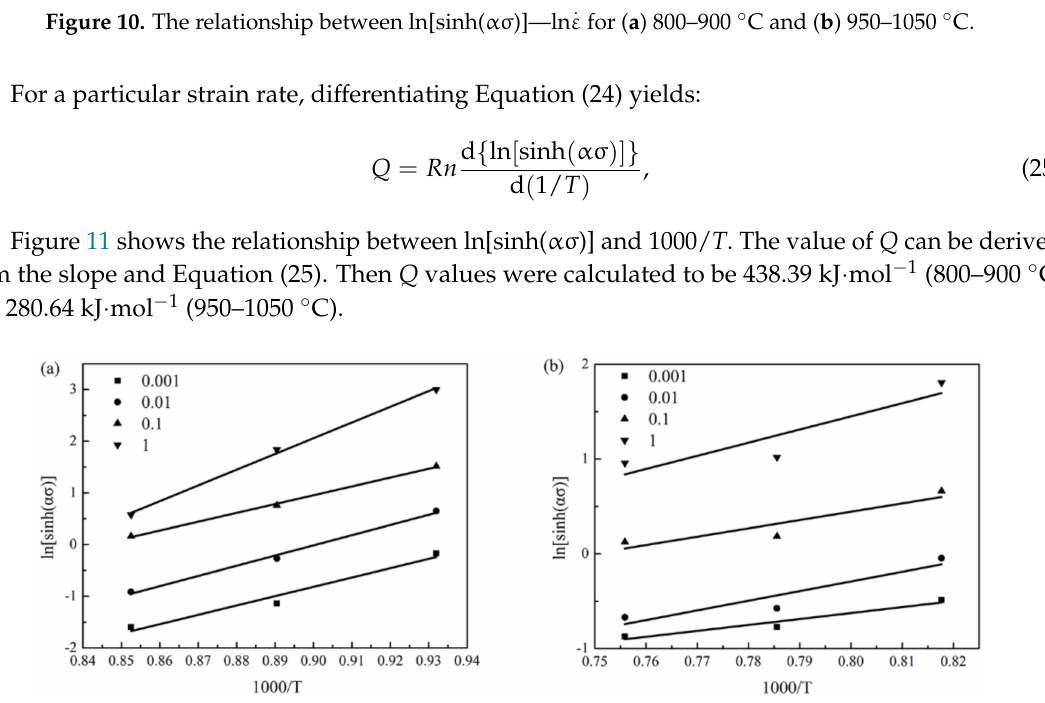
Figure 11. The relationship between ln[sinh( α σ )]—1000/ T for ( a ) 800–900 ◦ C and ( b ) 950–1050 ◦